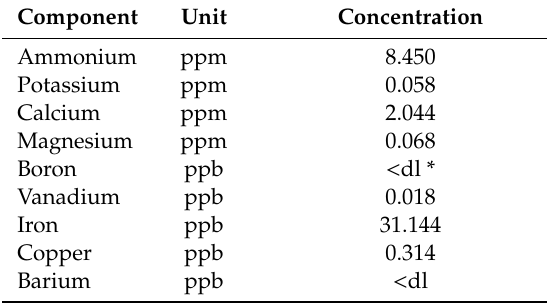
Table 3. Characterization of GTL produced water by